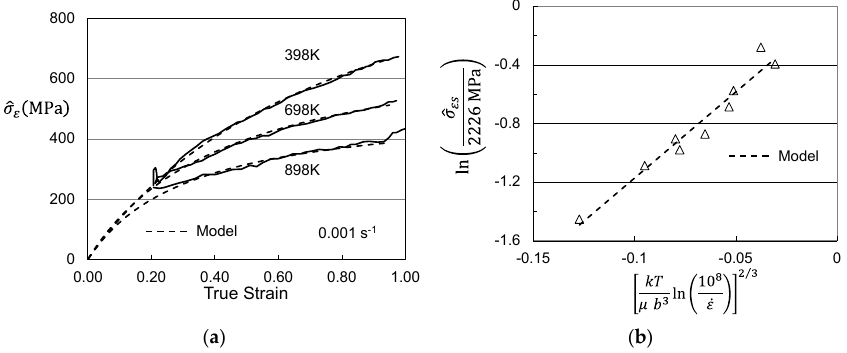
Figure 12. Assessed evolution for Cheng et al. molybdenum. ( a ) Variation with strain assuming an initial strain of 20%; ( b ) Saturation threshold stress according to Equation (5).